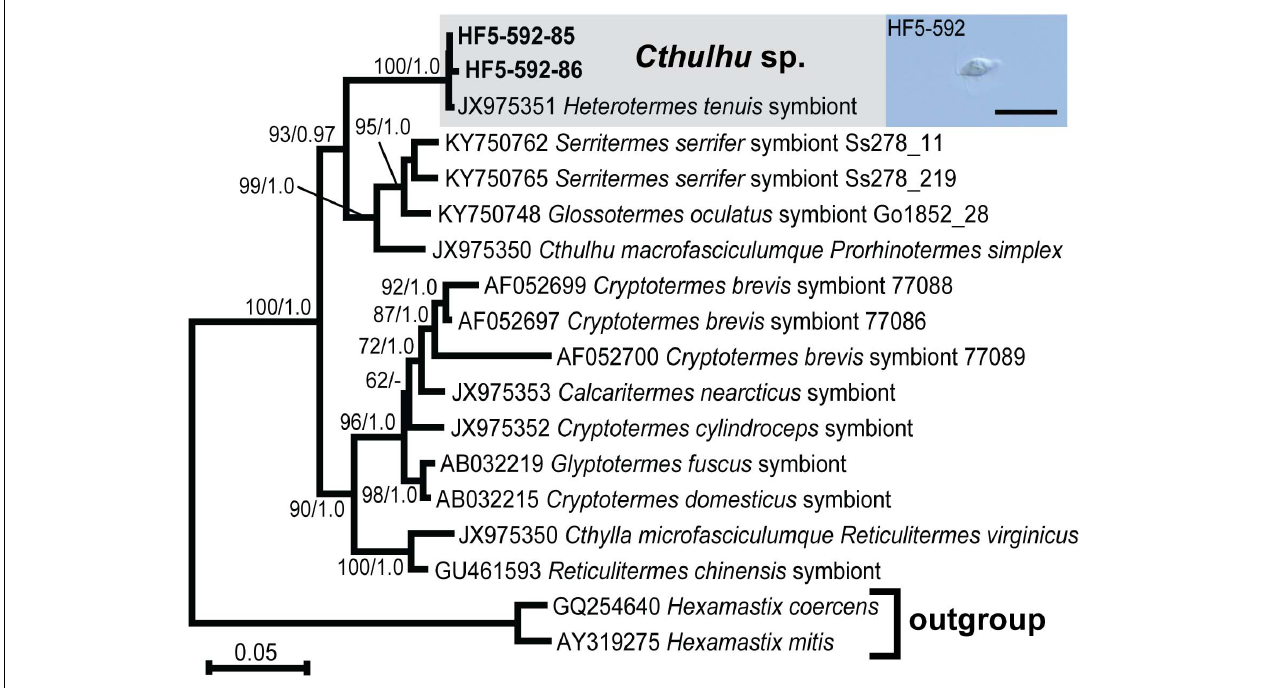
FIGURE 3 | Maximum likelihood phylogeny of 18S ribosomal RNA gene sequences from Cthulhu species with Hexamastix sequences as outgroup. Protist species-level phylotypes from H. tenuis are indicated by gray boxes and new sequences obtained in this study are indicated by bold text. Support at nodes is given out of 100 bootstrap replicates computed by RAxML/Bayesian posterior probabilities if greater than 60/0.95. New sequences from H. tenuis symbionts are indicated by bold text. Inset DIC micrograph features one of the eight pooled Cthulhu cells that were combined to generate the template for these sequences. Scale bar: 20 µ